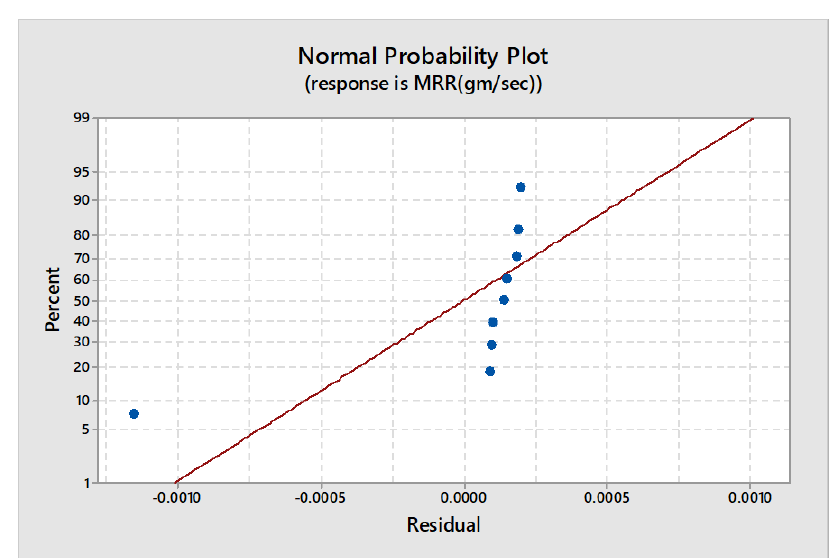
Fig. 3. Normal probability plot for